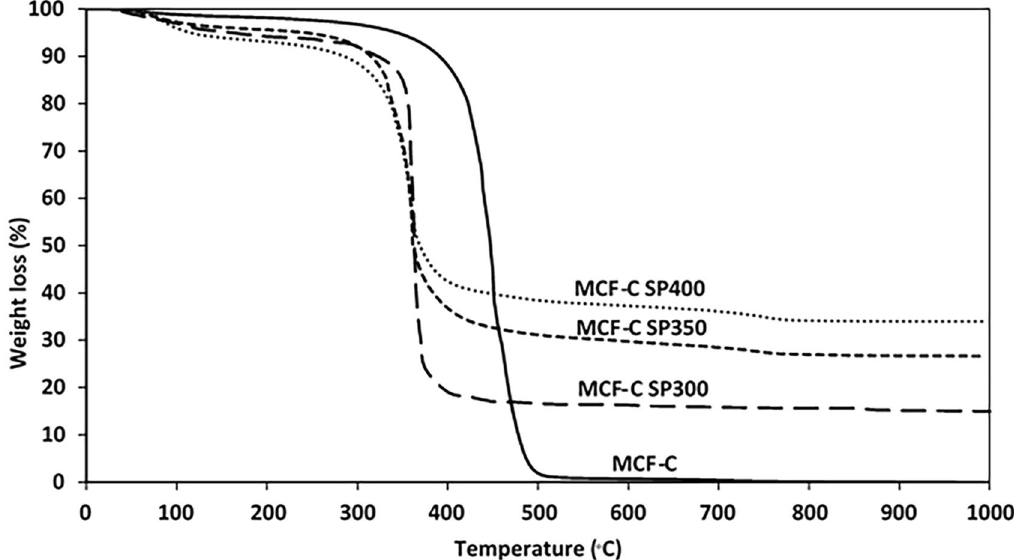
Figure 8. Thermogravimetric analysis (TGA) of material corresponding to each stability testing conditions of MCF-C under air atmosphere.